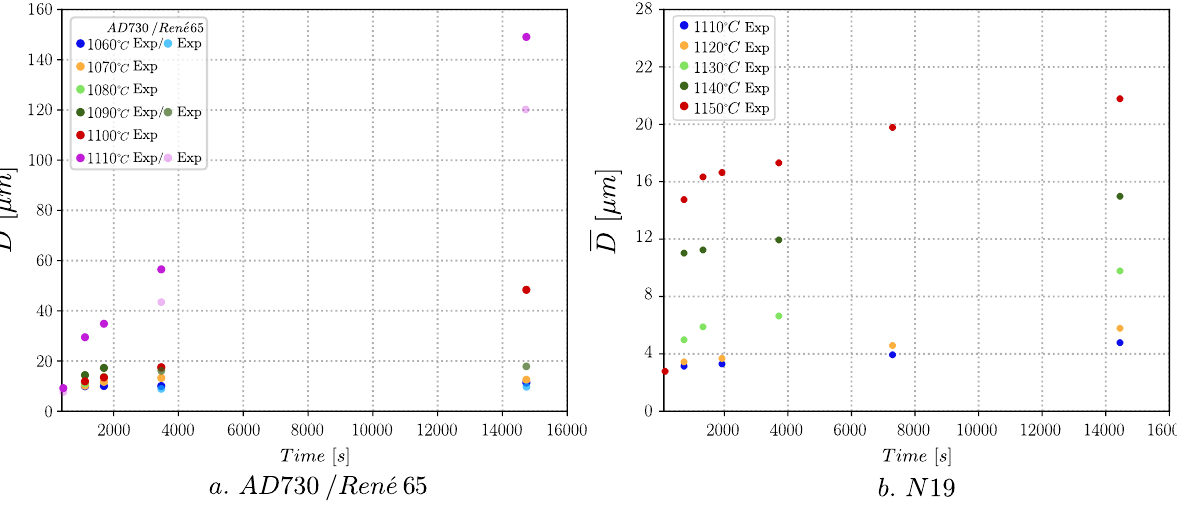
Figure 8. Mean grain size after subsolvus heat-treatments for ( a ) AD 730/ René 65 for ( b ) N 19